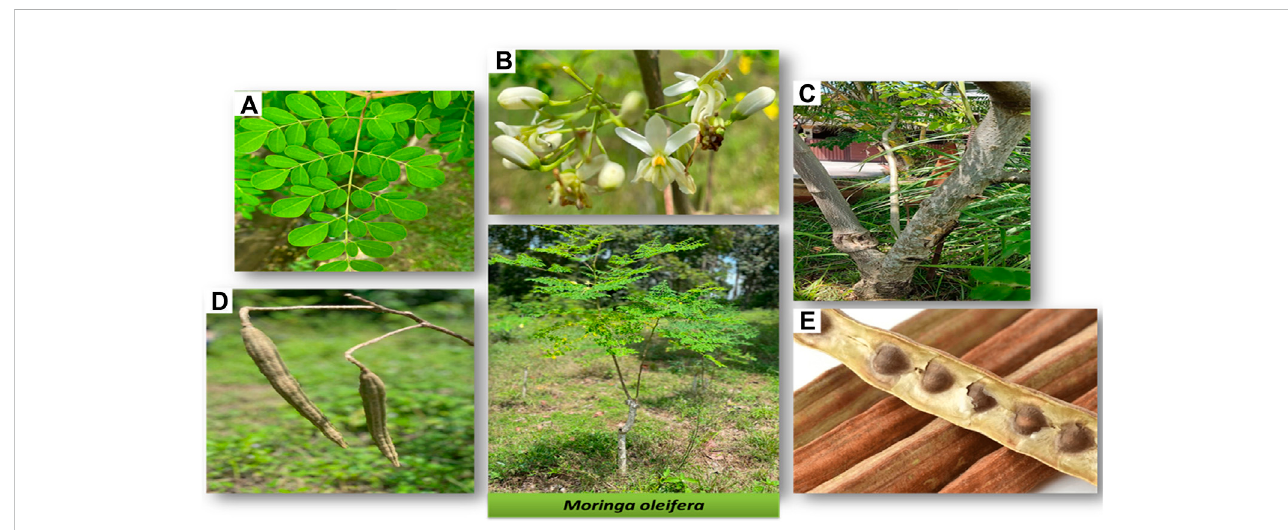
FIGURE 2 Different parts of M. oleifera tree (A) leaves, (B) fl owers and sepal, (C) stem and bark, (D) pods, and (E) seeds. Photos are from self-captured